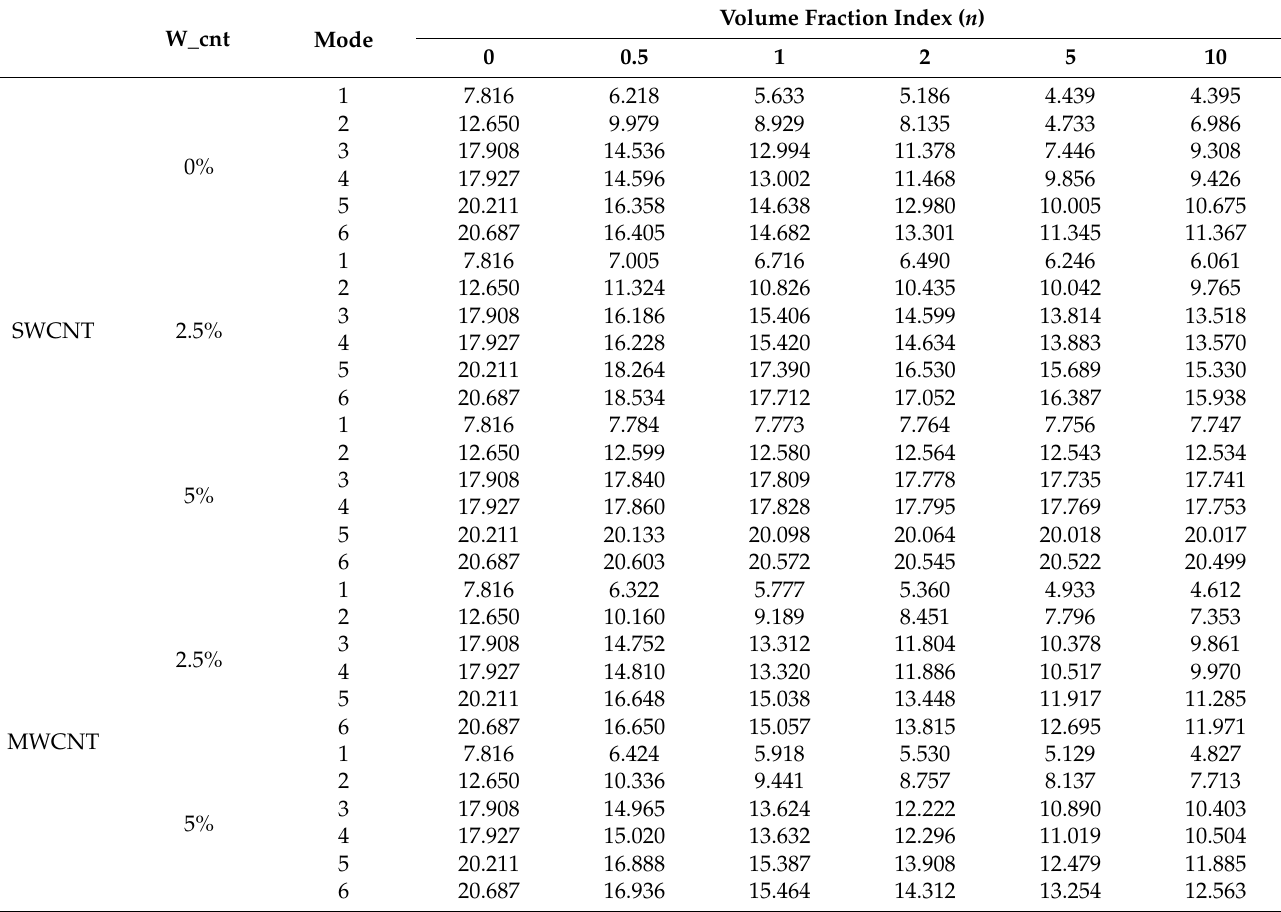
Table 5. Critical buckling load for the 1st six modes (Al/ZrO 2 ) under uniaxial